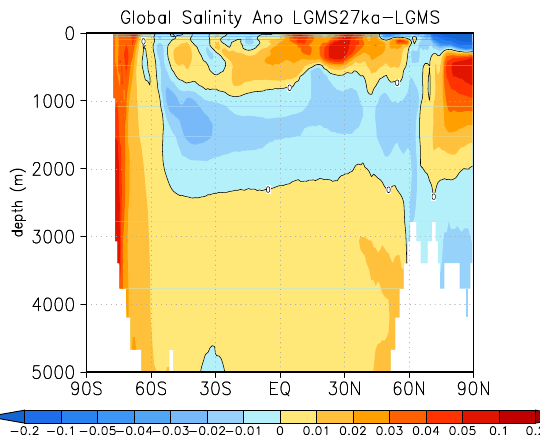
Fig. 11. Meridional section of zonal mean salinity anomalies Figure 11 Meridional section of zonal mean salinity anomalies (shaded) in (shaded) in global ocean between LGMS27ka and LGMS-e. For the global ocean between LGMS27ka and LGMS-e. For the comparison, we comparison, we averaged the corresponding model year 4600–4700 in both experiments. averaged the corresponding model year 4600-4700 in both experiments.